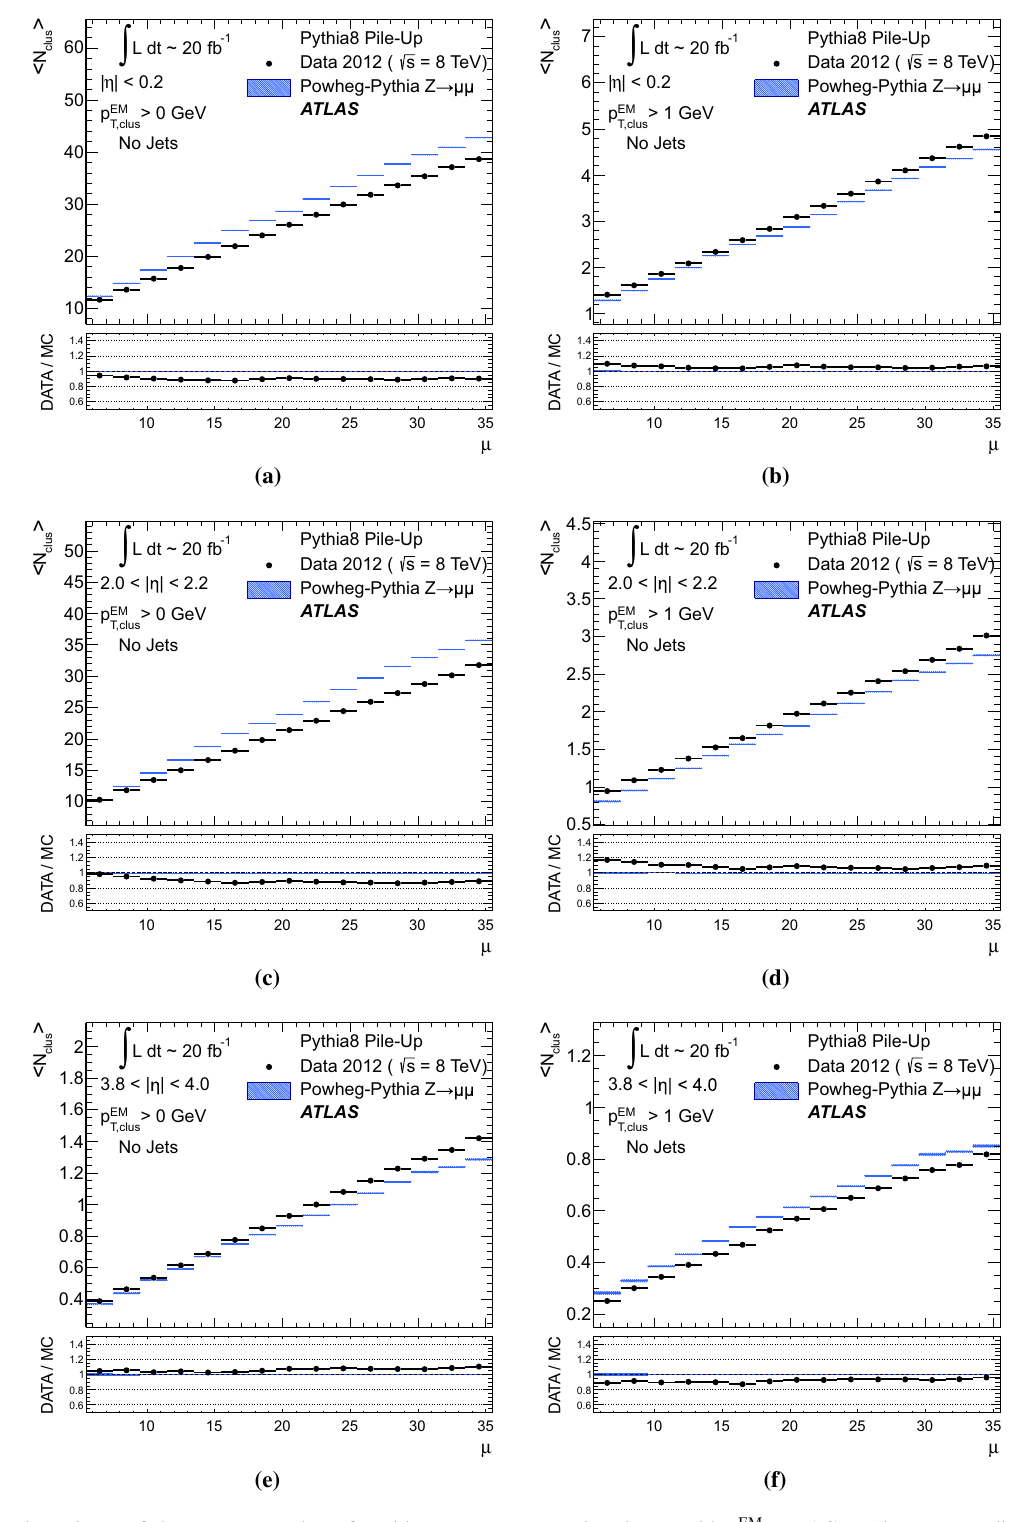
Fig. 27 The dependence of the average number of positive-energy topo-clusters on the pile-up activity measured by the number of proton– protoncollisionsperbunchcrossings μ inseveralregionsofthedetector is shown in a , b for | η | < 0 . 2, in c , d for 2 . 0 < | η | < 2 . 2, and in e , f for 3 . 8 < | η | < 4 . 0. Plots a , c and e show the results for counting > 0, while b , c and f show the results for only all clusters with p EM T , clus